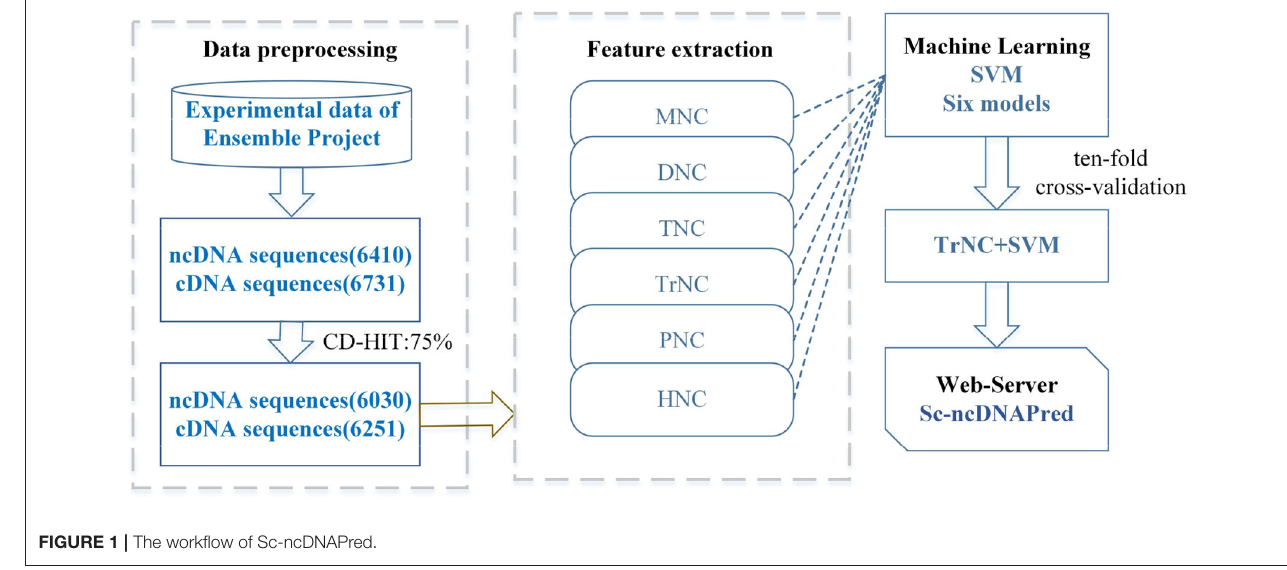
FIGURE 1 | The workflow of Sc-ncDNAPred.